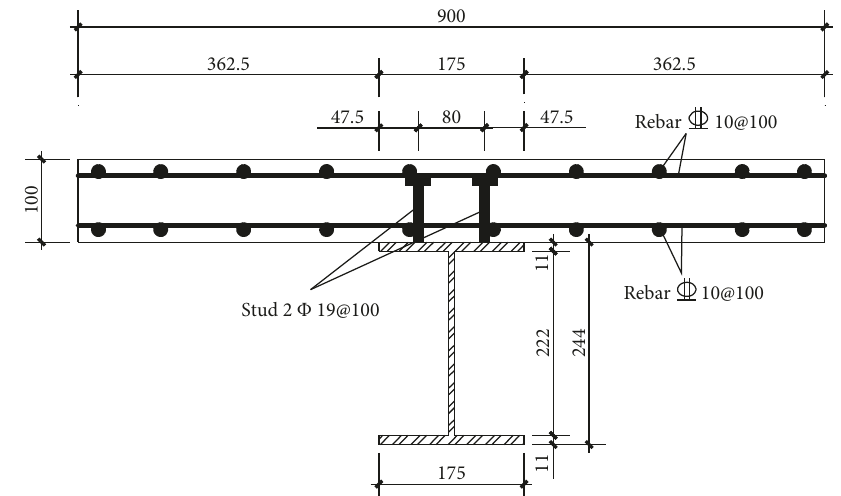
Figure 3: Section of the composite beam.